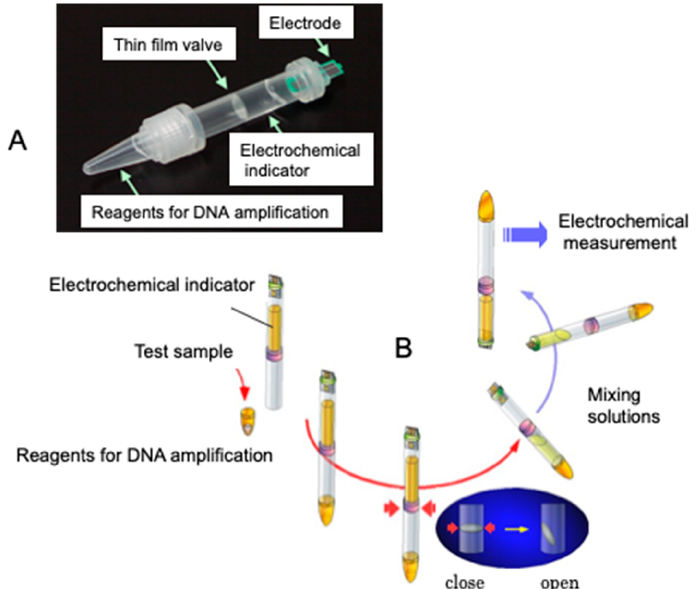
Figure 6. DNA stick for PCR amplification and electrochemical detection. ( A ): Structure of DNA stick; ( B ): Operation of DNA stick.